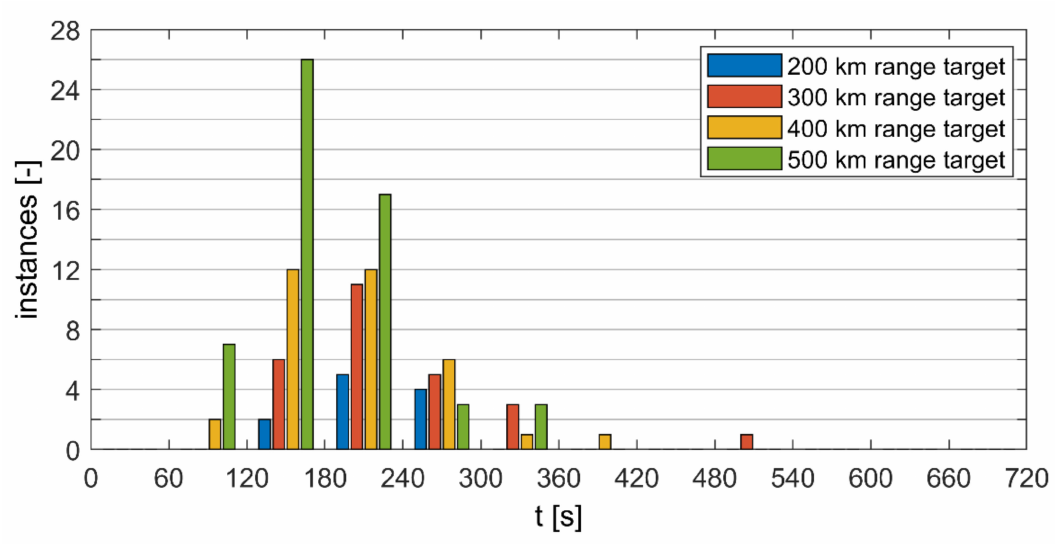
Figure 11. REX engagement instances binned by engagement time for FTP-75 and vehicle mass of 1500